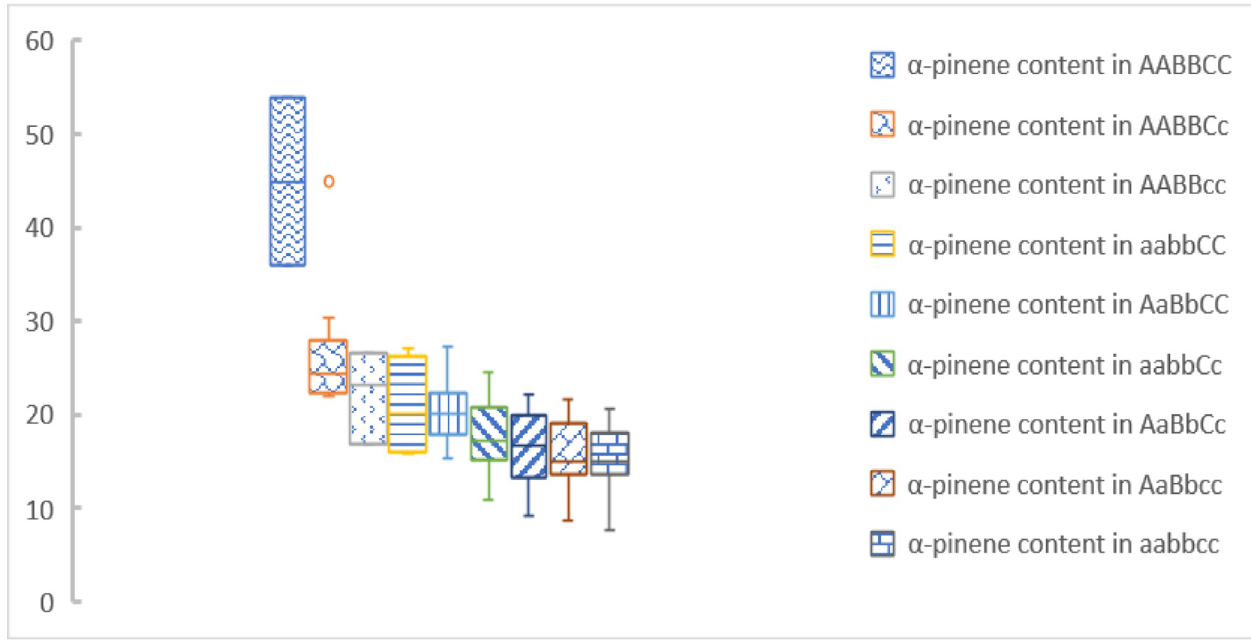
Fig 8. Box map of α -pinene content for 9 genotypes. Among them, the genotype AABBCC was only 1, and the box map was not drawn.